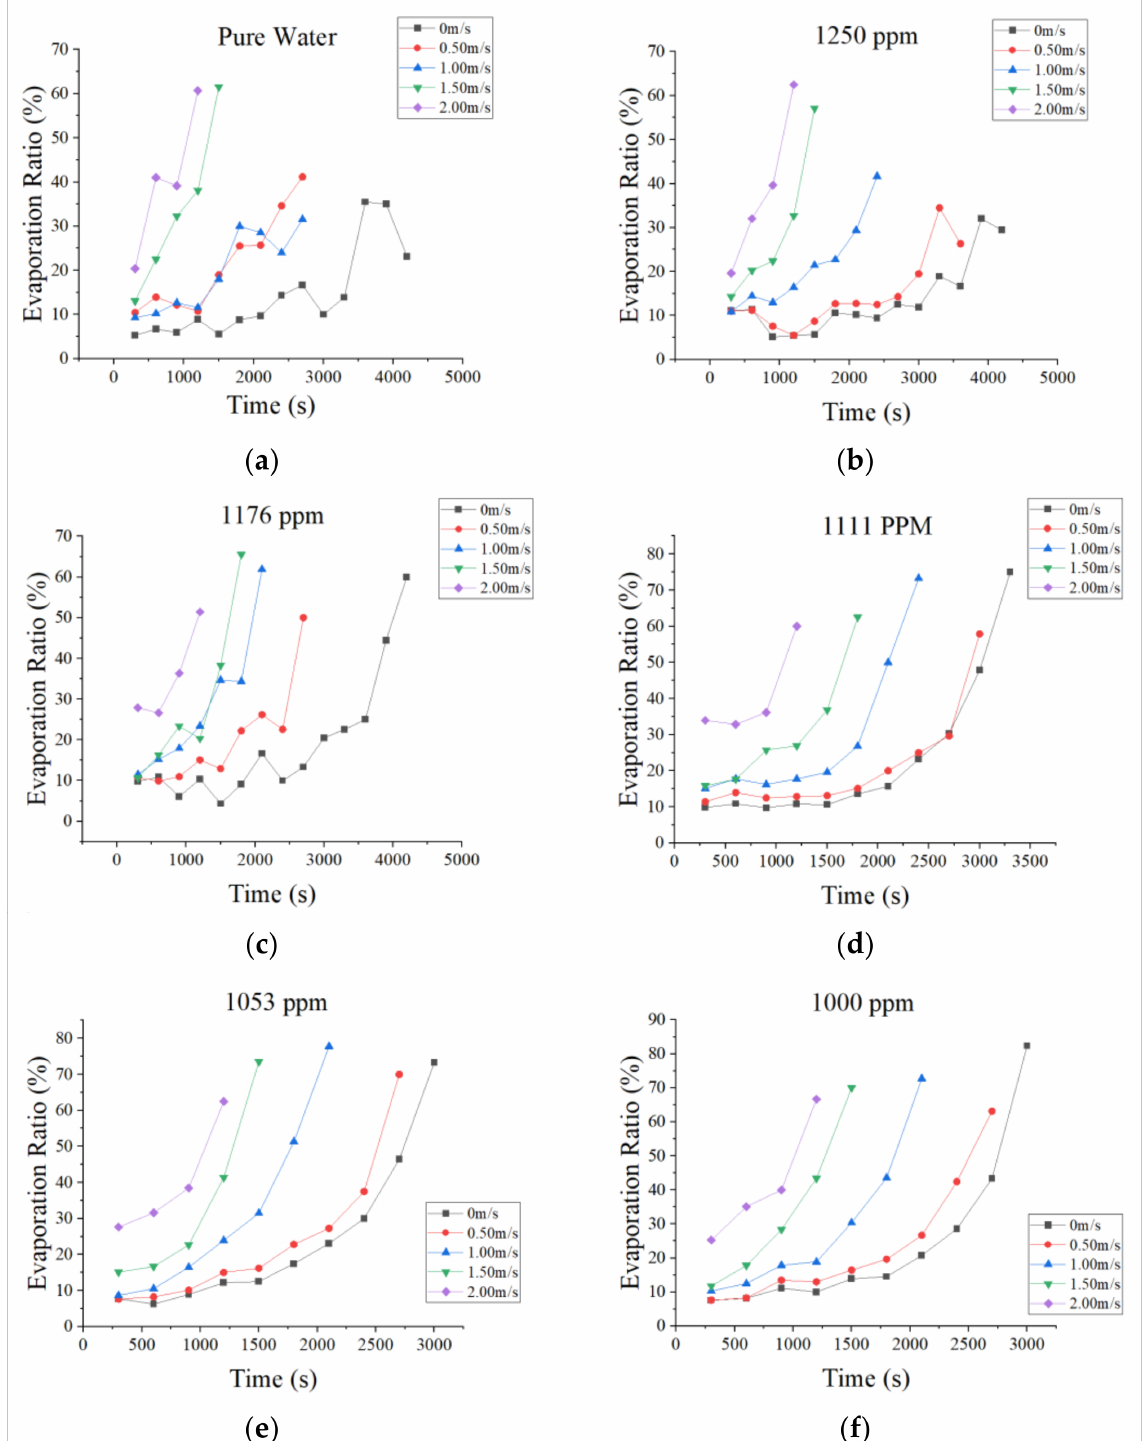
Figure 5. Variation of the evaporation ratio of different liquids on peach leaves: ( a ) pure